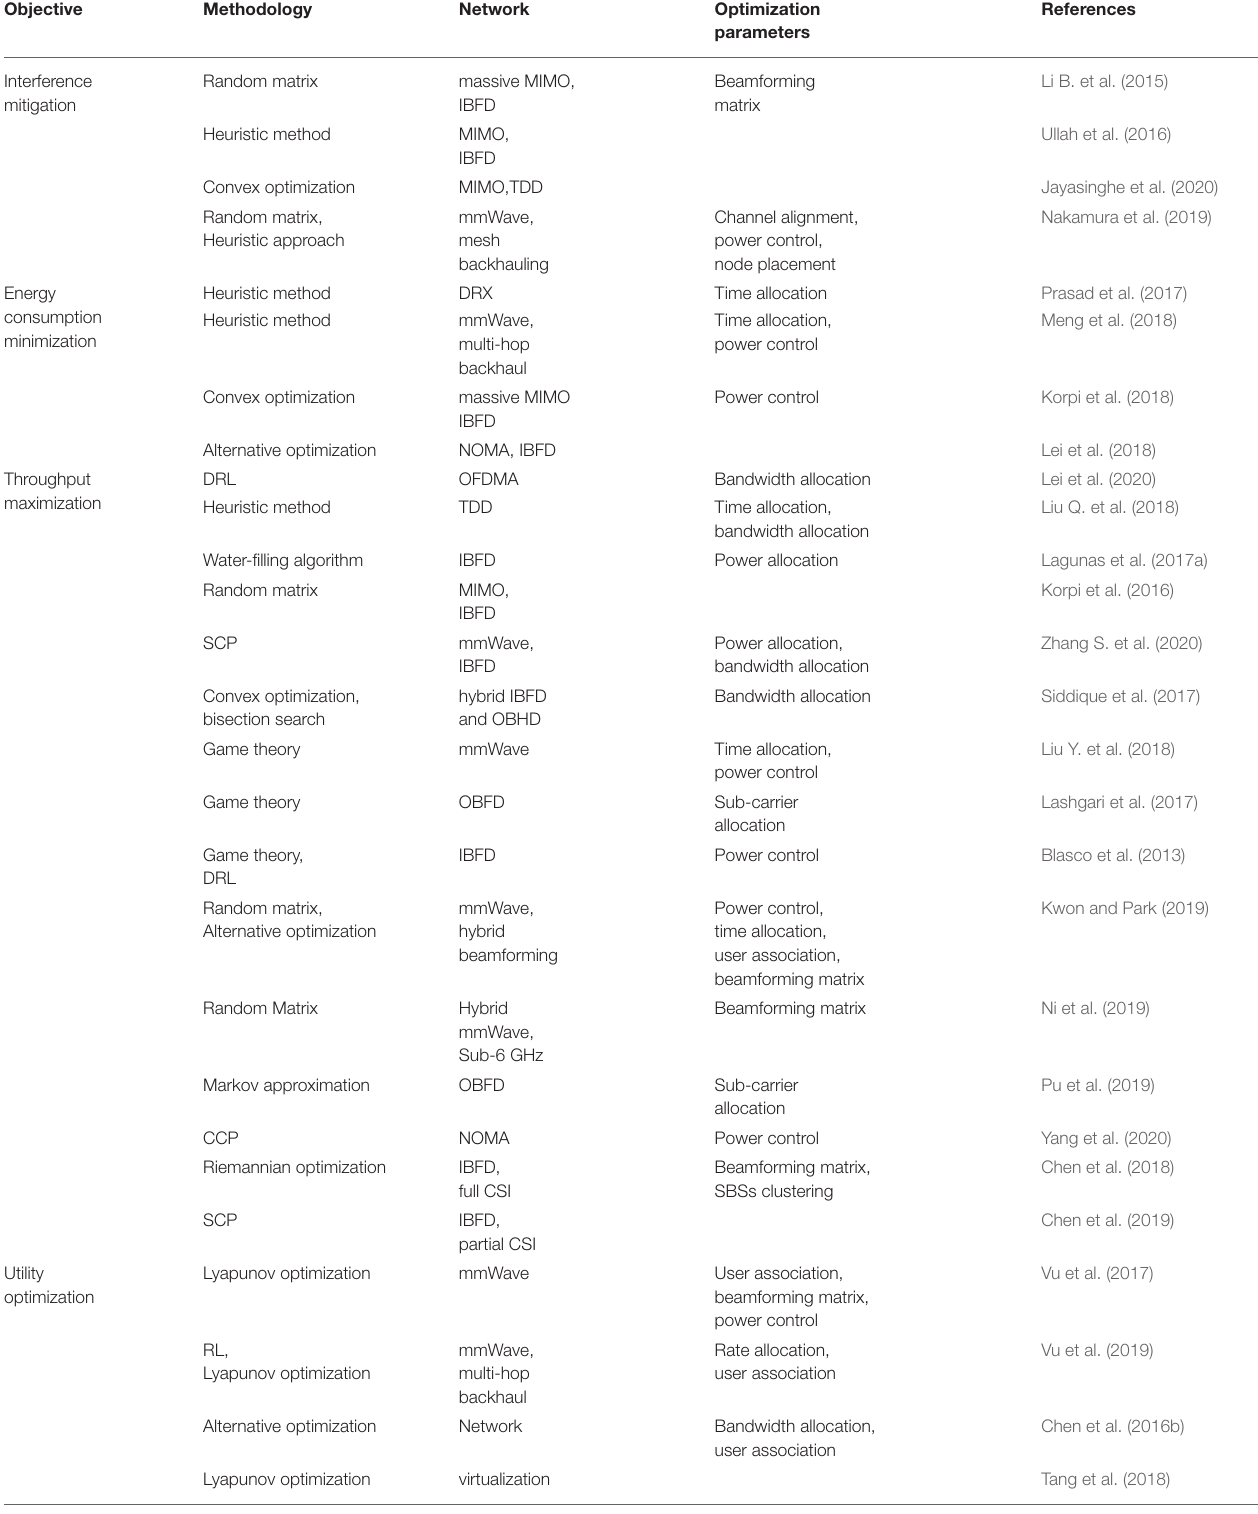
TABLE 2 | Taxonomy of literature in section